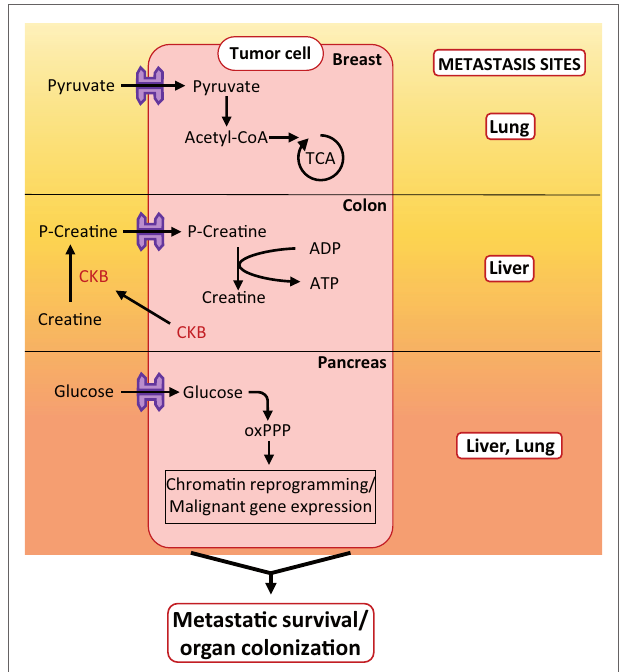
FiGURe 2 | Metabolic phenomenon occurring in metastasis sites. Example of metabolic pathways activated in breast, colon, and pancreatic metastatic cells during colonization of lung, liver, and liver/lung, respectively. Abbreviations: oxPPP, oxidative branch of the pentose phosphate pathway; CKB, brain-type creatine